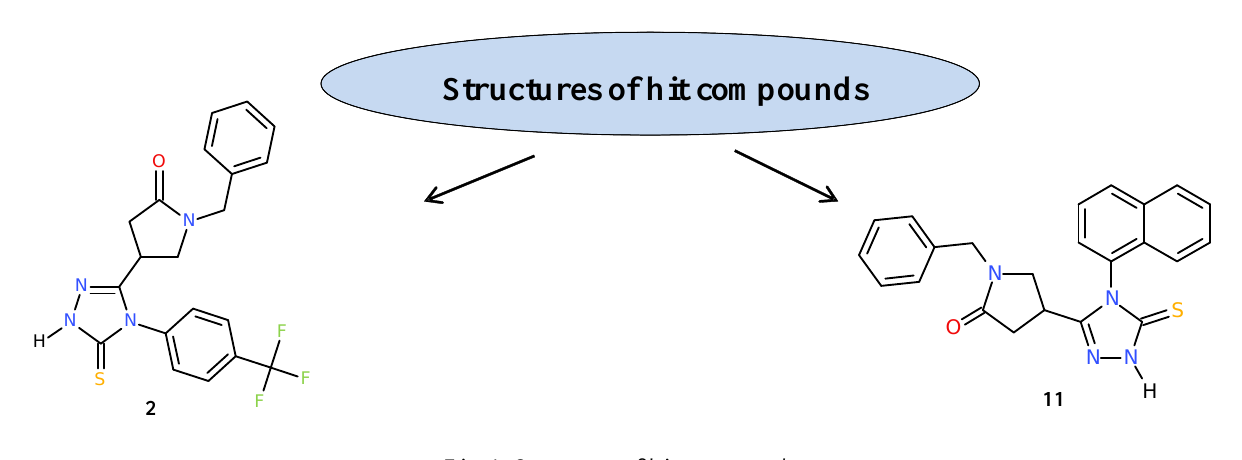
Fig. 1. Structures of hit compounds